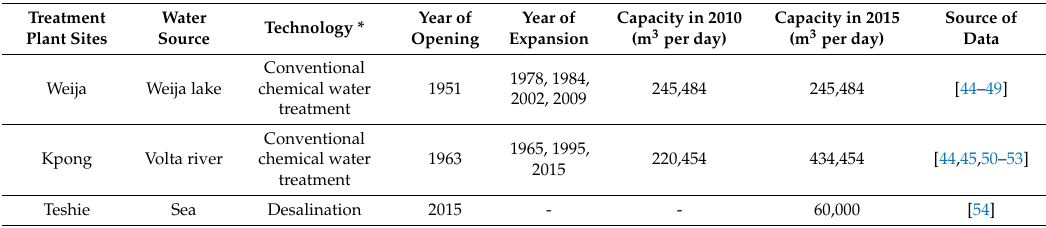
Table 2. Overview of potable water treatment plants in